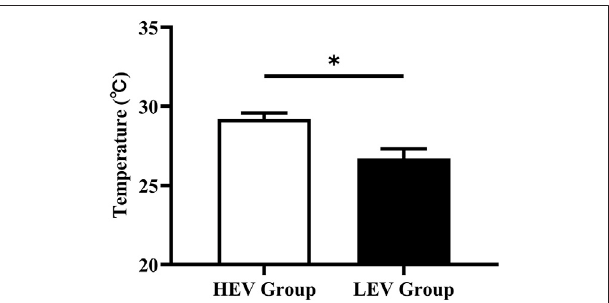
FIGURE 4 | Results of skin temperature of plantar tissue in participants (Mean with SEM). HEV: High Exercise Volume ( ≥ 27 Mets · h/week); LEV: Low ExerciseVolume( < 27Mets ·